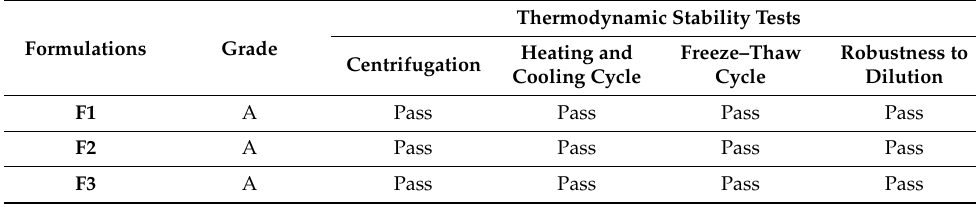
Table 2. Thermodynamic stability of the curcumin-loaded